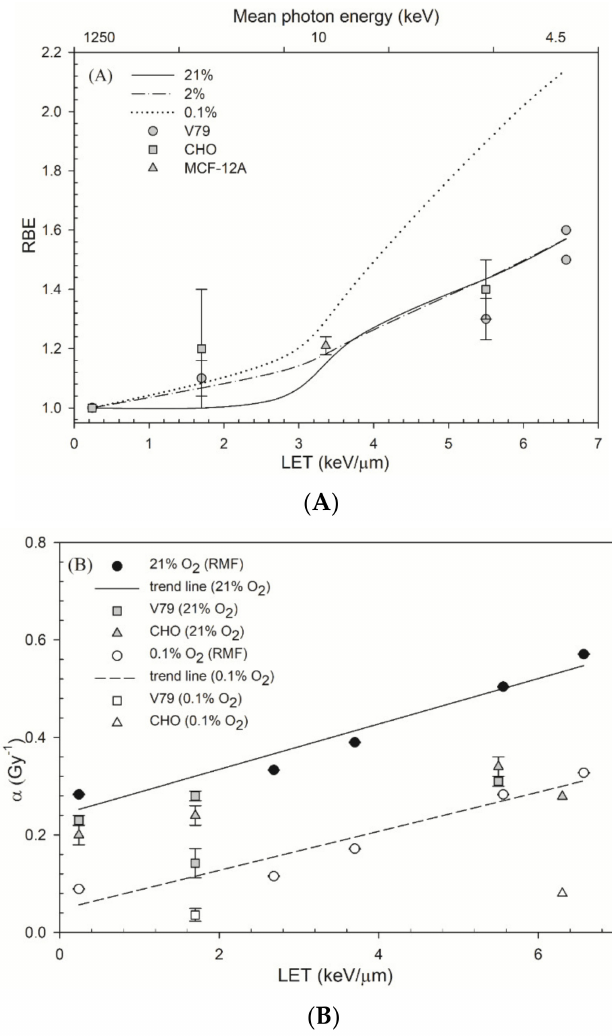
Figure 3. Relative biological effectiveness (RBE) values for cells irradiated by ultrasoft X-rays as a function of linear energy transfer ( LET ). ( A ) The repair–misrepair–fixation (RMF)-model-predicted RBE values for cell survival at 10% are plotted for oxygen concentrations of 21% (solid line), 2% (dash-dotted line) and 0.1% (dotted line). The experimental RBE values were measured at an oxygen concentration of 21% O 2 for V79 cells [17,75,76], Chinese hamster ovary (CHO) cells [75] and human mammary epithelial cell line MCF-12A [77] after photon irradiations. ( B )The values for parameter α using RMF model: the equations for the α value under aerobic and hypoxic conditions are, respectively, α = 0.0466 × LET + 0.2412 (R 2 = 0.9443) (21% O 2 ) and α = 0.0402 × LET + 0.0466 (R 2 = 0.9161 ) (0.1% O 2 ). These measured α values are from published studies: CHO cells and V79 cells irradiated with photons at an aerobic condition (21% O 2 ) [61,71,75] and at a hypoxic condition (0.1% O 2 )